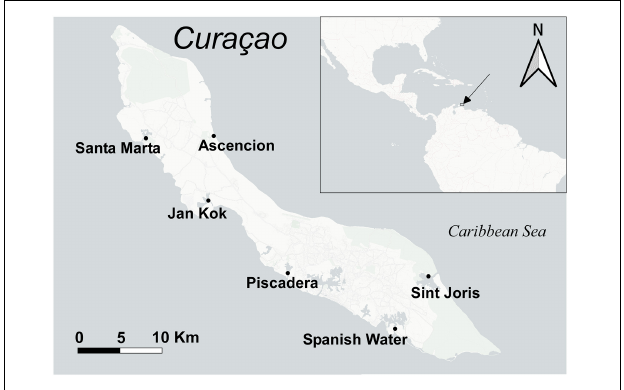
FIGURE 1 | Sampling locations for the seagrasses around the Island of Curaçao. Sampling of each seagrass species was distributed as follows (with three replicates each for roots and leaves separately): Santa Marta— H. stipulacea + two seawater and three sediment samples; Jan Kok— T. testudinum , H. wrightii , and H. stipulacea + three seawater and three sediment samples; Piscadera— T. testudinum and H. stipulacea + two seawater and three sediment samples; Spanish Water— T. testudinum , H. wrightii , and H. stipulacea + four seawater and four sediment samples; Sint Joris— T. testudinum and H. stipulacea + one seawater and three sediment samples; Ascencion— T. testudinum and H. wrightii + two seawater and four sediment